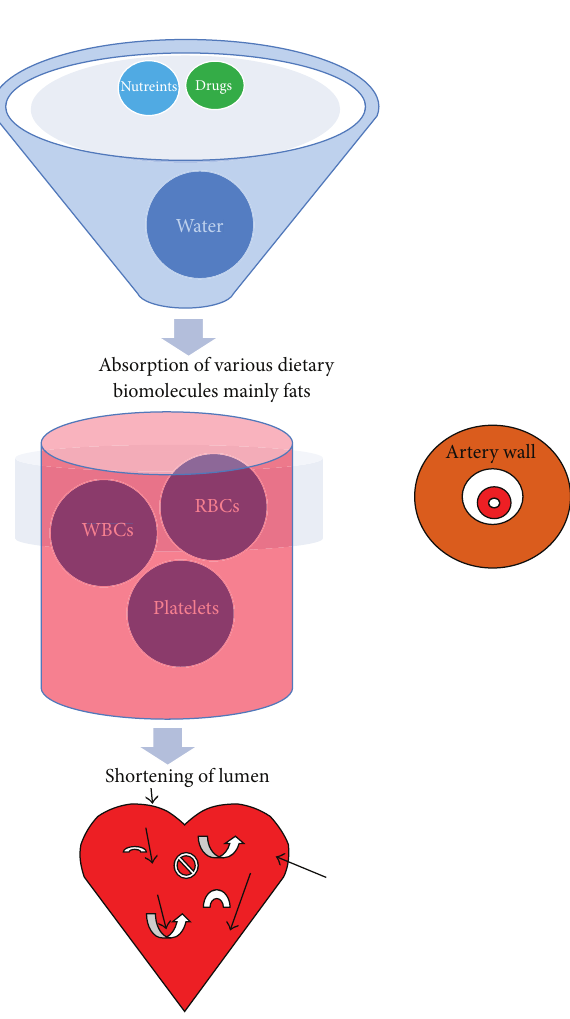
Figure 6: Shortening of artery wall due to deposition of cholesterol and its binding